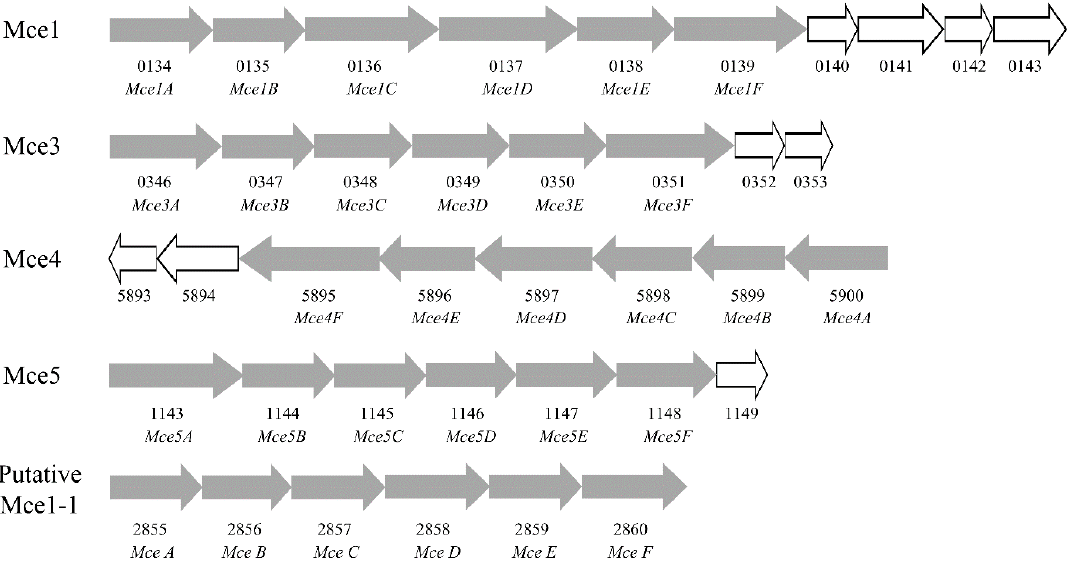
Figure 5. The organization of the MCE operons in M. smegmatis MC 2 155 genome. The operon structures of the five MCE operons are shown. The grey arrows represent MCE genes, while the white arrows represent other MCE related genes.